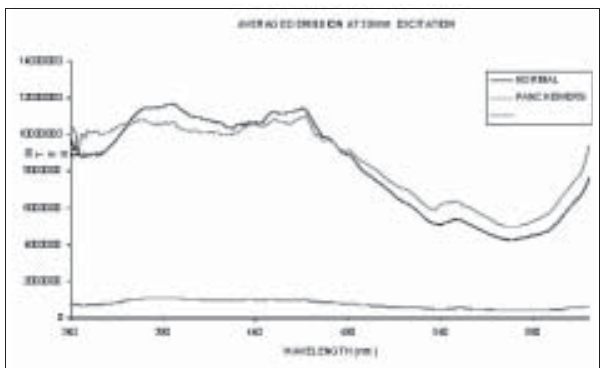
Fig. 2 - Averaged fluorescence emission spectra of normal, pan